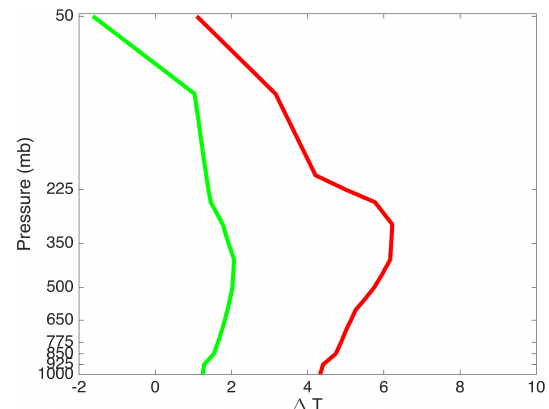
Figure 3. Upper (red) and lower (green) bounds of the area- averaged temperature changes, as represented by the 14 CMIP5 models listed in Table 2, using the RCP4.5 and RCP8.5